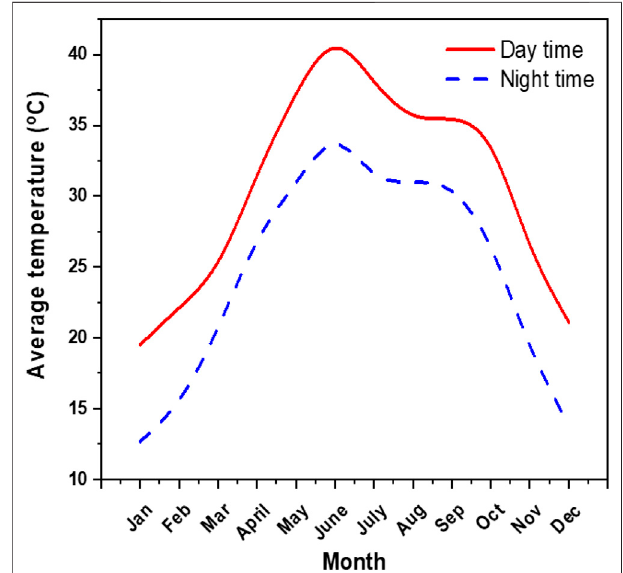
FIGURE 5 | Average change in day and nighttime temperature for the year 2019 for the city of Lahore.